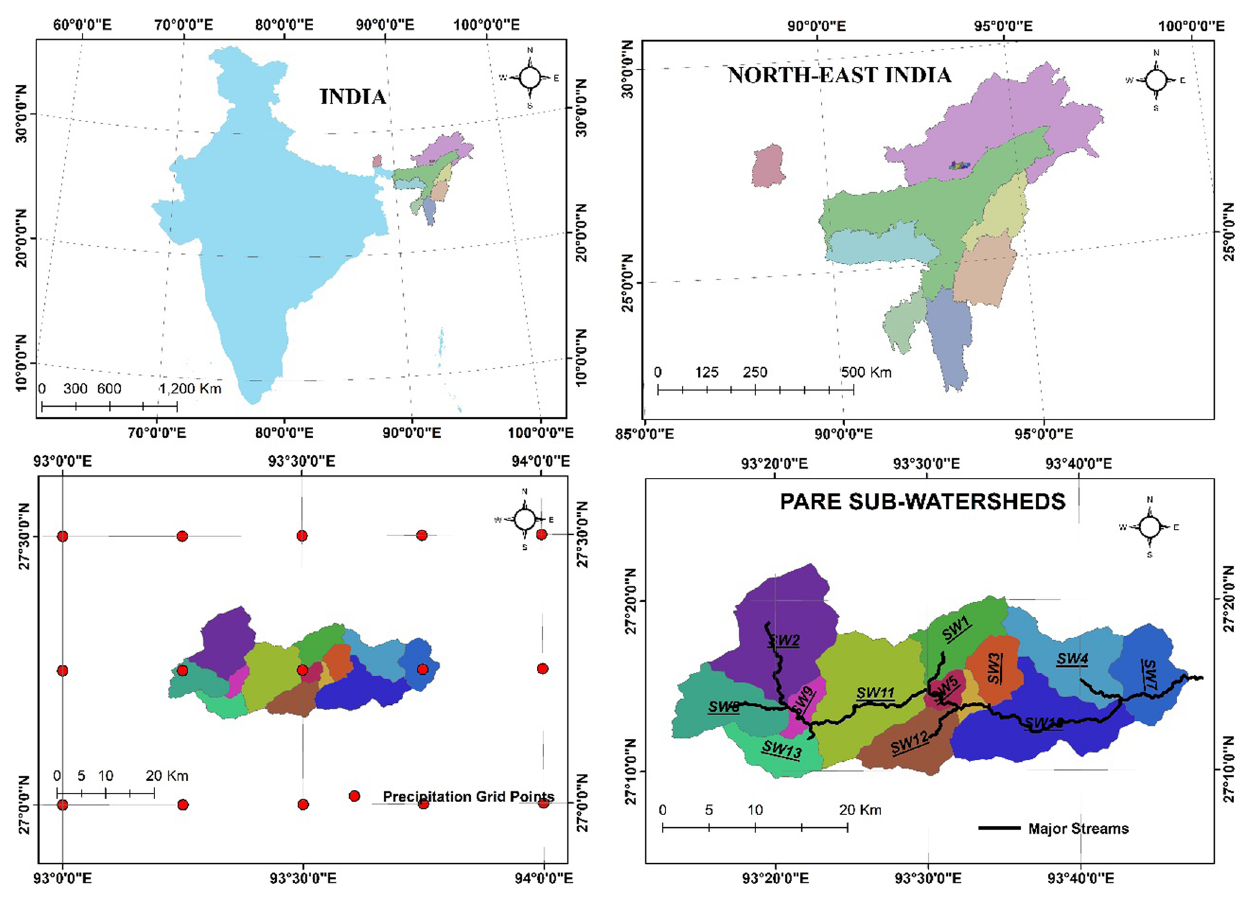
Fig. 1 Map of the study area—Pare watershed and its 13 subwatersheds